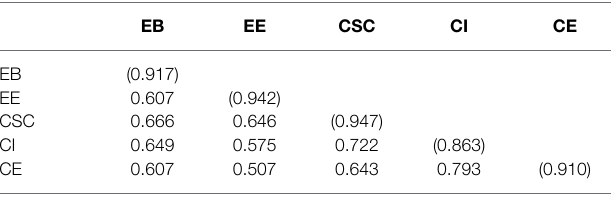
TABLE 1 | Correlation coefficient matrix between latent